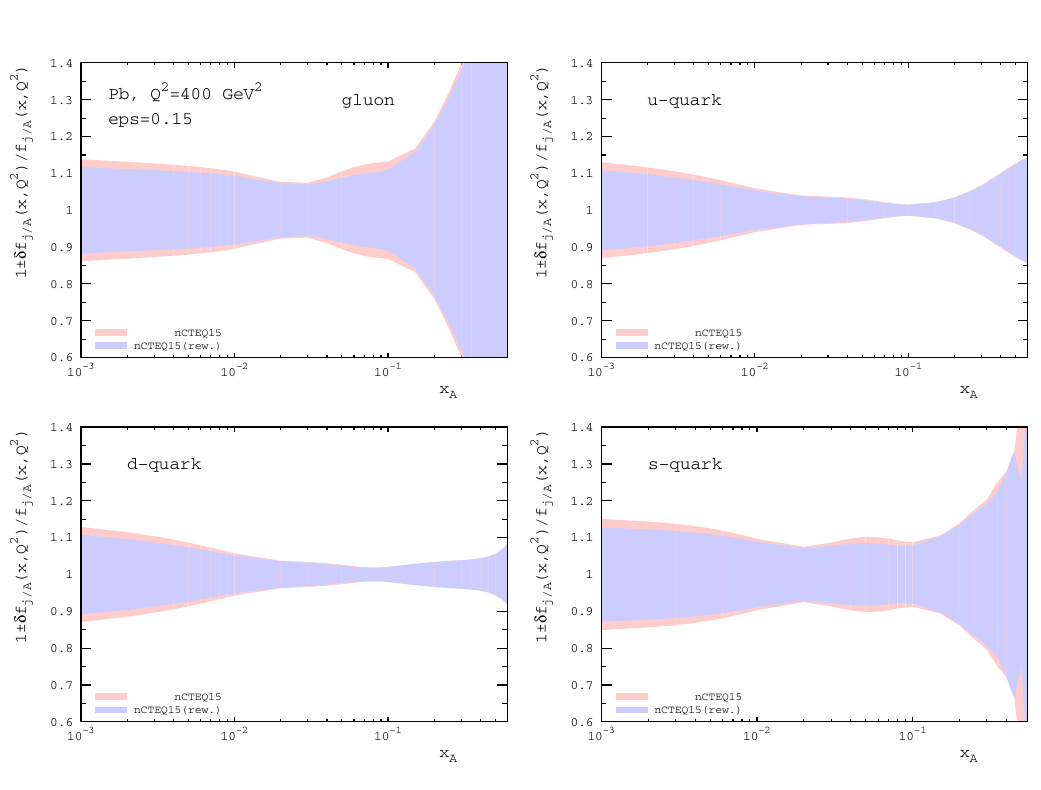
Fig. 3 The same as Fig. 3, but with (cid:6) = 0 . 1